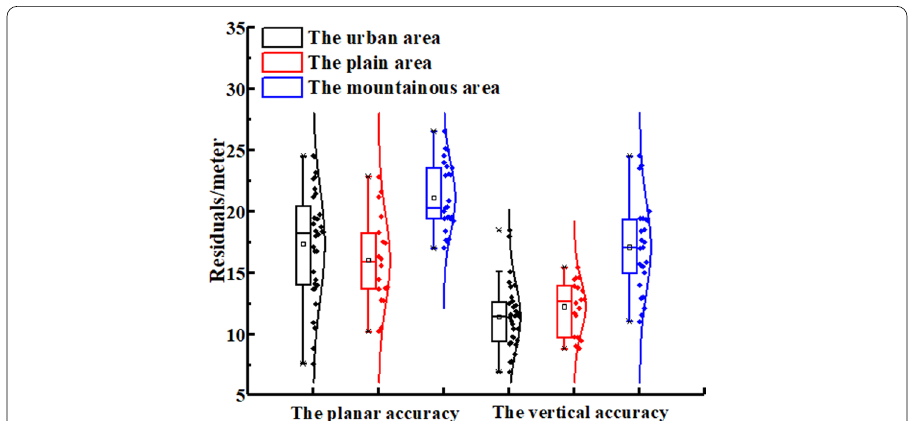
Fig. 5 Results of the direct positioning accuracy obtained using the vendor-provided RPCs. The x-axis is divided into the planar and vertical accuracies. The geometric positioning residuals and Gauss fitting curves for the three study areas for each of these categories are presented. The y-axis shows the corresponding residual values